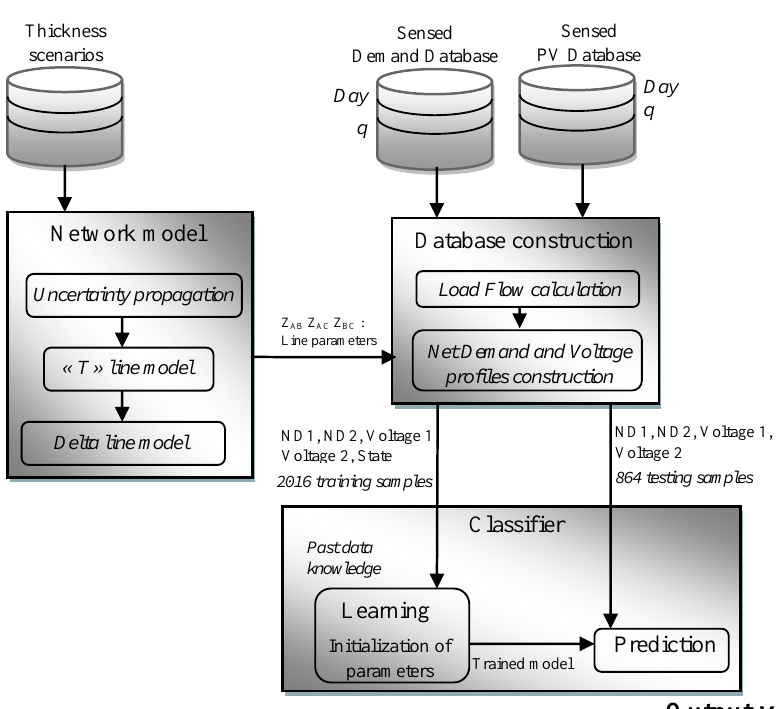
Figure A1. Global flowchart of the implemented process.